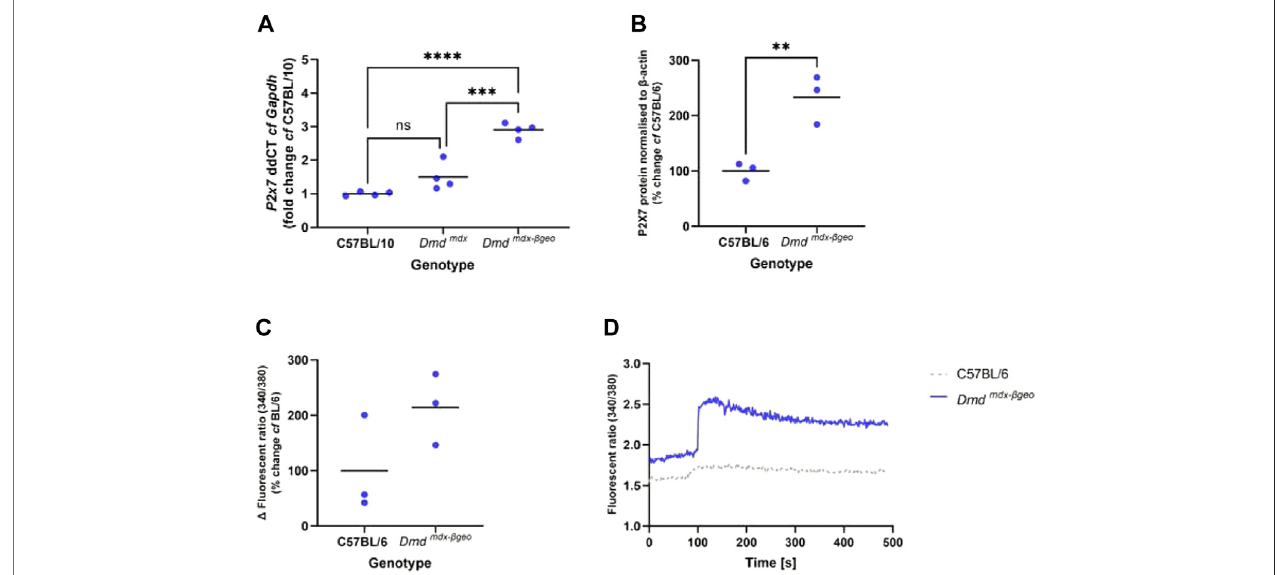
FIGURE 1 | P2X7 receptor expression and function in Dmd mdx- β Geo tissues. (A) qPCR analysis of P2x7 gene expression in tibialisanterior muscle from Dmd mdx- β Geo micecomparedto Dmd mdx (***= p < 0.001)andwildtype(****= p < 0.0001),ANOVAwithTukey'sposttests. (B). WesternblotanalysisofP2X7proteinexpressioninmouse BMMshowingtwiceasmuchP2X7in Dmd mdx- β Geo micecomparedtoC57BL/6controls(**= p < 0.01,unpairedt-test). (C). P2X7activationwasmeasuredwiththecalcium in fl ux assay, showing increased P2X7 activity in Dmd mdx- β Geo peritoneal macrophages. (D). Representative traces showing clear differences in P2X7 activation in C57BL/6 and Dmd mdx- β geo